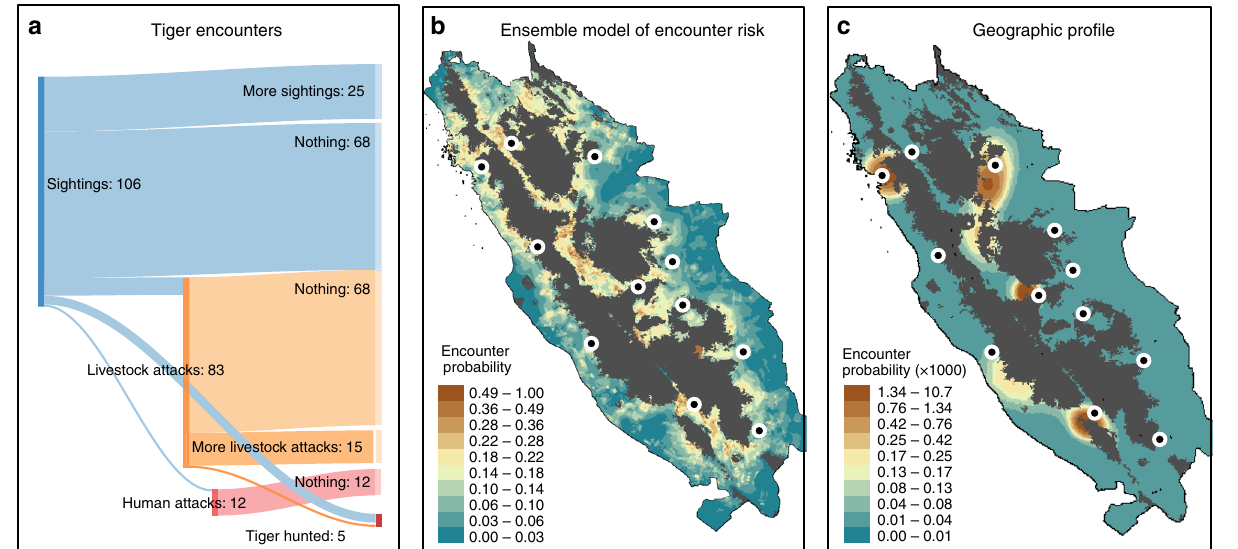
Fig. 1 Tiger encounters over Kerinci Seblat between 2000 and 2013. a Sankey diagram of the progression of human – tiger encounters from sightings (blue), through to attacks on livestock (orange) and people (red), and tigers hunted. Encounters are linked if they occurred <6 months apart in the same village. The overall number of tigers hunted was 27, of which 5 were linked to previous encounters. b Risk of encounter predicted by an ensemble of binomial models, or c a geographic pro fi le based on all 228 reported encounters 2000 – 2013. Locations of the study areas are shown by points. Probabilities across the entire geographic pro fi le sum to